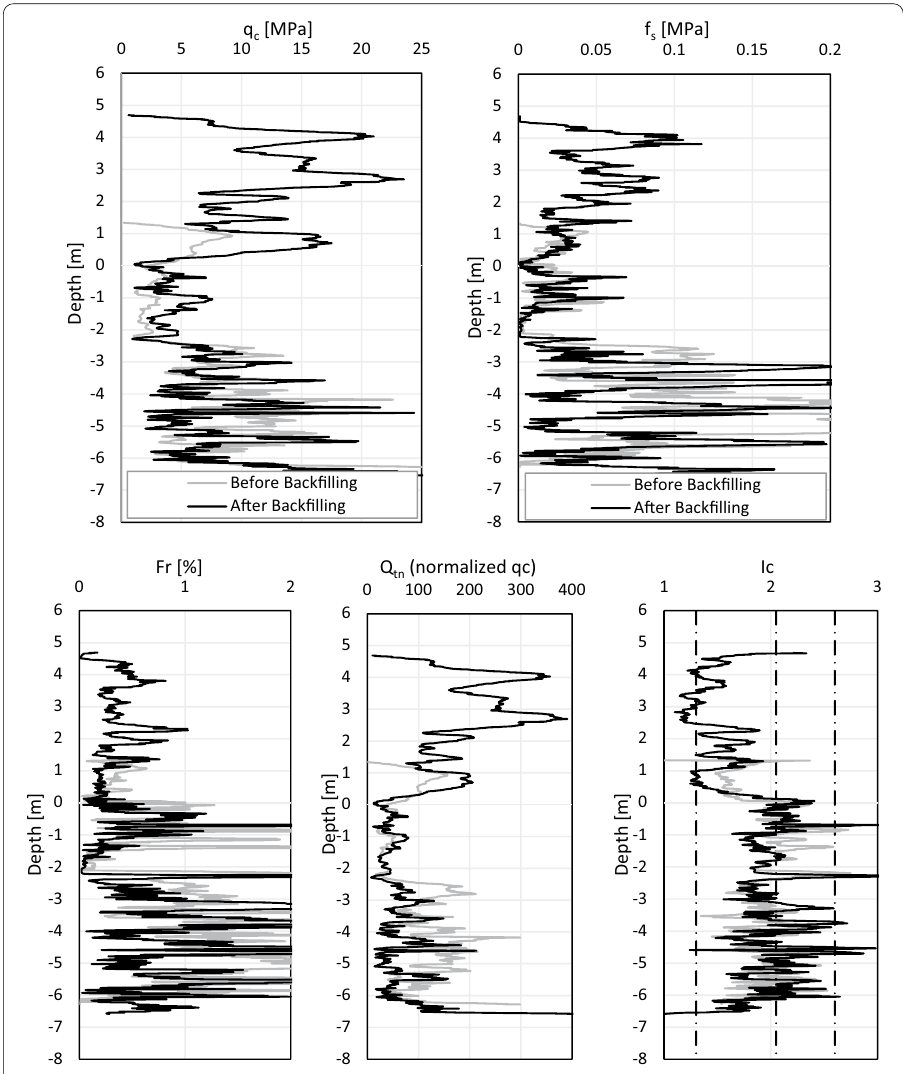
Fig. 2 q c , f s , F r , Q tn , and I c of pre and post CPTs case